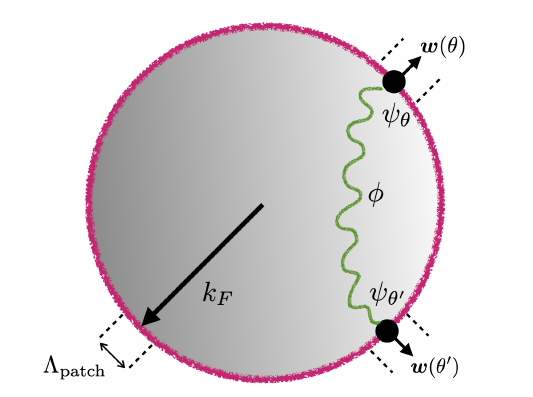
Figure 1: Schematic picture of the patch decomposition and “mid-IR” effective theory. We divide the Fermi surface into patches indexed by angles θ = 2 π/ N (cid:28) k each of width Λ . Each patch is associated with a fermion field, ψ θ , and a F patch unit normal, w ( θ ) . We couple the Fermi surface to a bosonic field, φ scatter fermions within a particular patch. While we neglect scattering of a fermion from one patch into another, we still allow the boson to mediate interactions between all of the patches (denoted by the wavy